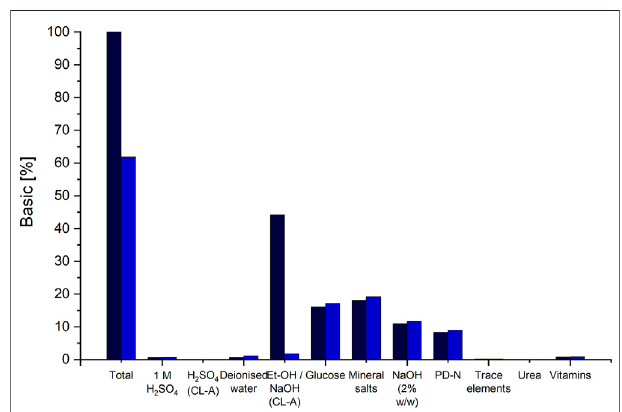
FIGURE 4 | Distribution of raw material cost-shares on the different chemicals and substrates used for fermentation and DSP. The cost shares of the basic scenario are indicated via the black columns and the cost shares for scenario 12, applying the DSP method using alkaline hydrolysis and precipitationtoCL-A,areindicatedinblue. Thecolumn “ Et-OH/NaOH (CL-A)" indicates the cost shares of ethanol, for the basic DSP method and the cost shares for NaOH in scenario